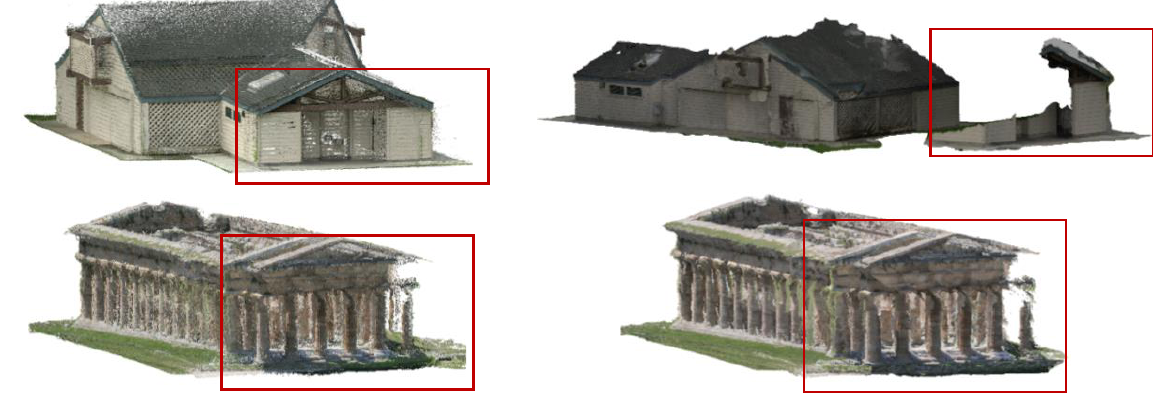
Figure 2. Examples of badly reconstructed dense clouds (drift effect) because of erroneously oriented images. Up: Barn_TaT dataset oriented with COLMAP -sequential (left) and AliceVision -SIFT-incremental (right). Bottom: Nettuno_aerial dataset, AliceVision+COLMAP (left), AliceVision+OpenMVS (right).